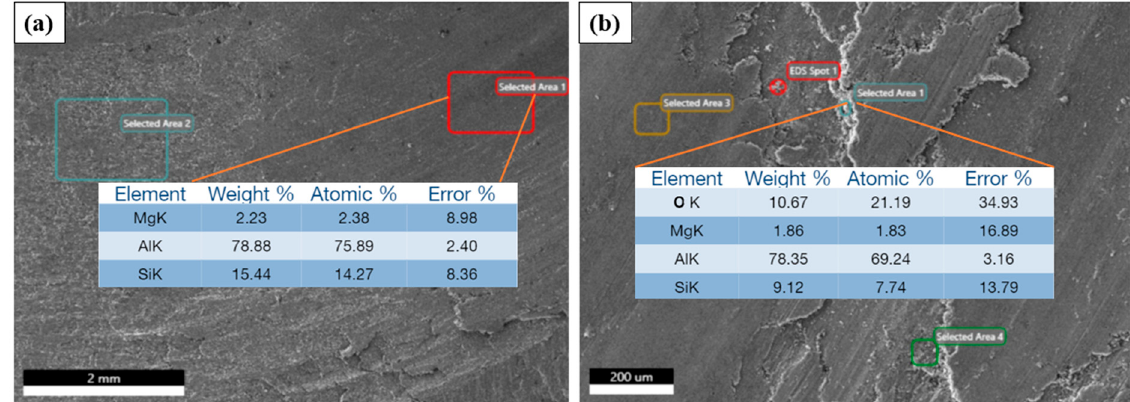
Figure 9. Comparative element weight distribution derived from EDS spot analysis on SEM images of MMC at ( a ) room temperature and ( b ) elevated temperature of 175 °C.